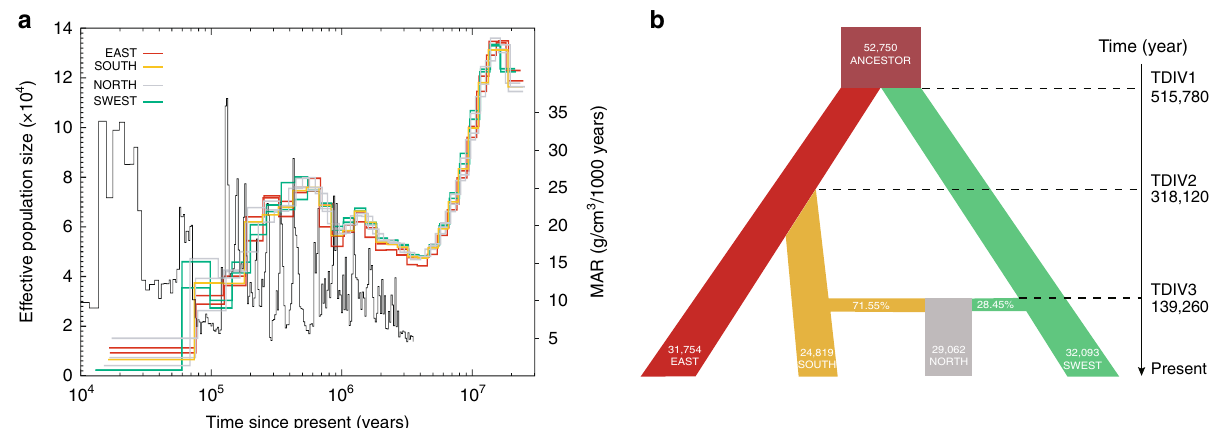
Fig. 2 Demographic history of ginkgo populations. a Demographic history of four ginkgo lineages including the populations in eastern China (EAST), southern China (SOUTH), northern China (NORTH), and southwestern China (SWEST) inferred by PSMC. The mass accumulation rate (MAR) of Chinese loess is shown in black line. b Schematic of demographic scenarios modeled using fastsimcoal2 , with the ancestral population shown in brown. Column width represents the relative effective population size, with the NORTH lineage inferred as a mixture of 71.55% of the SOUTH lineage and 28.45% of the SWEST lineage. The numbers on the vertical axis indicate the estimated time of population